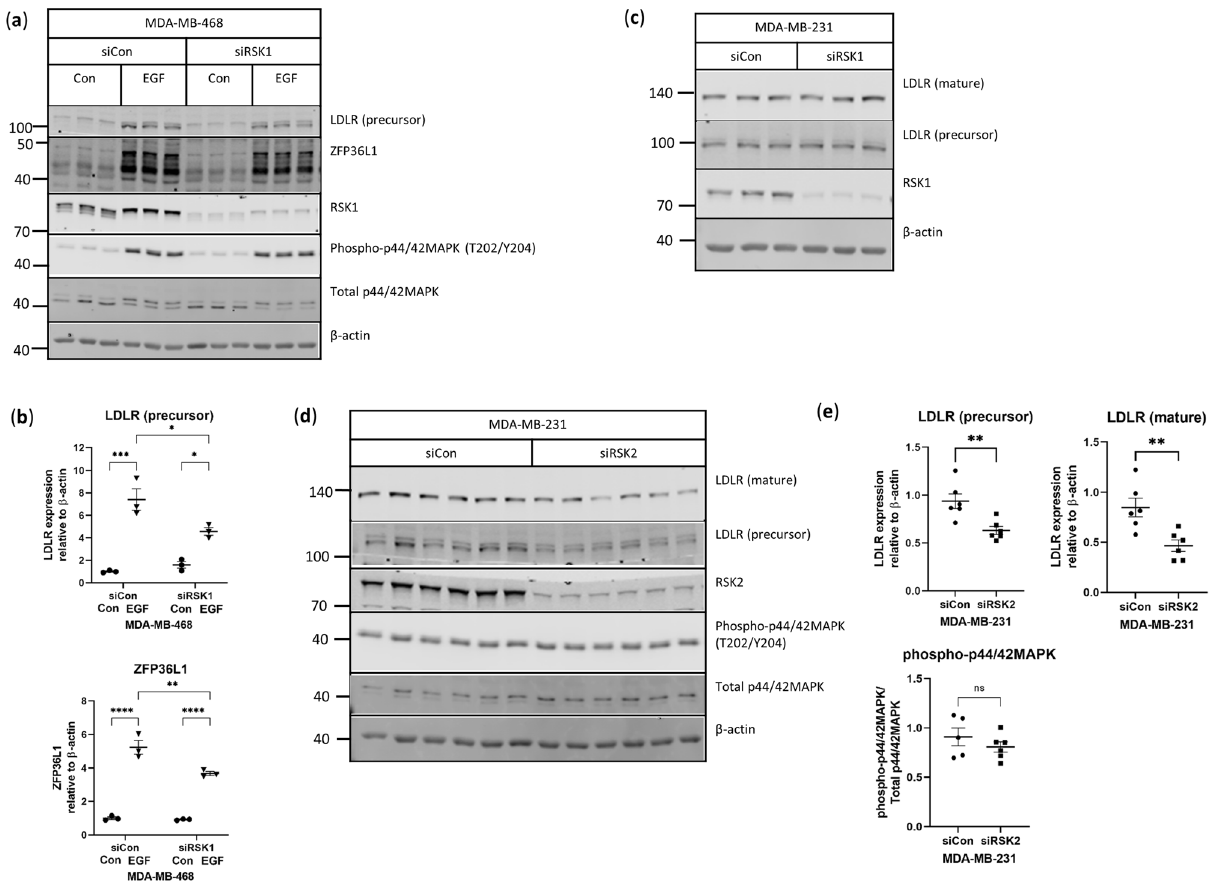
Figure 7. RSK1/2 regulates LDLR expression in MDA-MB-468 and MDA-MB-231 cells. MDA468 cells were transfected with control siRNA or siRNA targeted to RSK1 for 72 h and stimulated with 10 ng/mL EGF for two hours prior to analysis by ( a , b ) western blotting for protein expression, n = 3 per condition. Uncropped blots are shown in Supplementary Fig. S15. ( c ) Representative western blot of MDA231 cells transfected with control siRNA or siRNA targeted to RSK1 for 72 h. Uncropped blots are shown in Supplementary Fig. S16. n = 3 per condition. ( d ) Representative western blot of MDA231 cells transfected with control siRNA or siRNA targeted to RSK2 for 72 h. Uncropped blots are shown in Supplementary Fig. S17. n = 6 per condition. Horizontal line indicates mean of the groups, error bars are S.E.M. Brackets indicate groups significantly different, *indicates p < 0.05 between groups, **p < 0.01, ***p < 0.001, ****p <